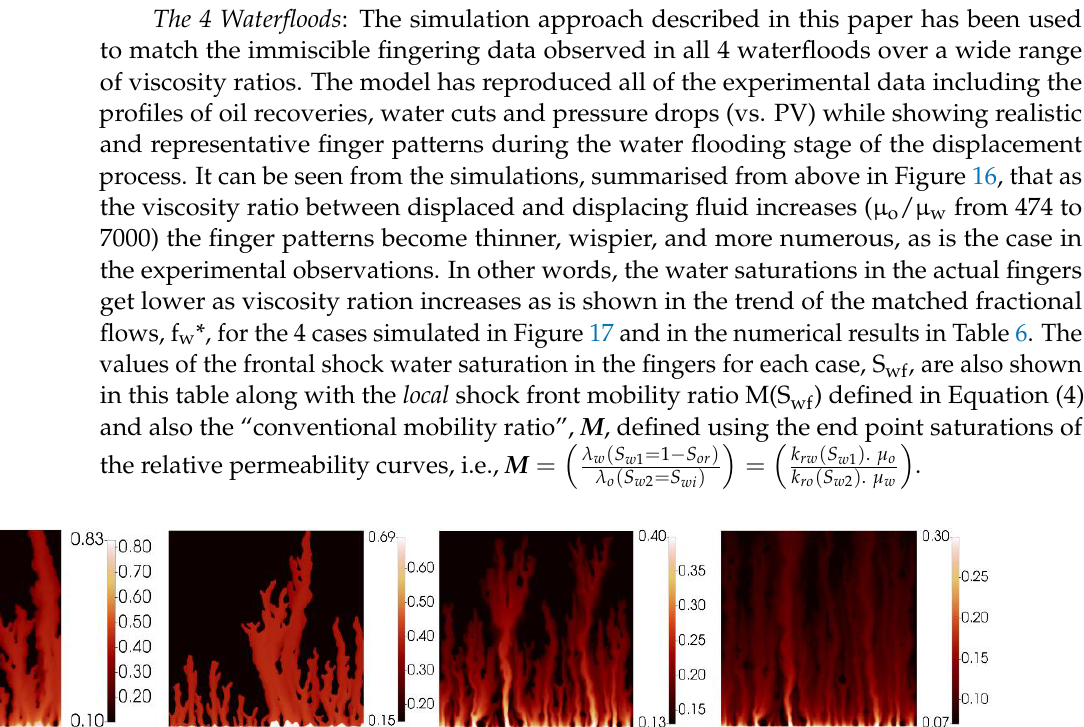
Figure 17. Summary of the matched fractional flow curves (f w *) for the 4 water flooding cases sim- ulated in this work. Table 6. Water saturations, finger mobilities and end point mobility ( M ) for the 4 water flooding cases. Oil Viscosity (mPa.s)